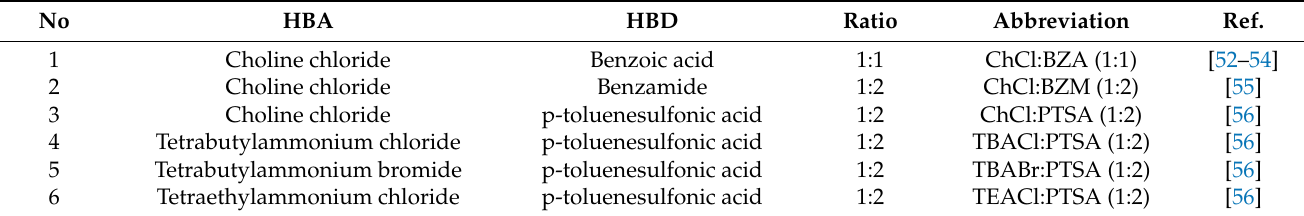
Table 3. List of ESs screened in this work using COSMO-RS with their